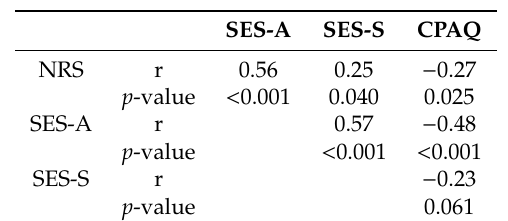
Table 2. Correlations between the measures at pre-treatment. N =